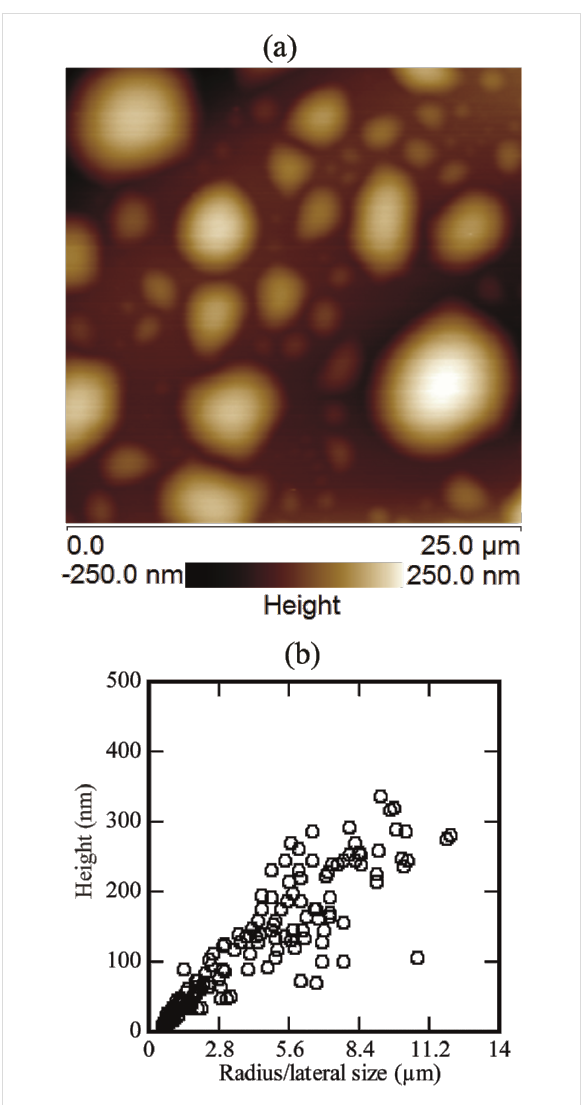
Figure 2: (a) AFM image of micro/nano spherical domains on a PS-coated surface, immersed in DI water. A number of spherical or nearly spherical objects can be seen in the image. (b) Summary of the height and radius/lateral size of the spherical domains. Additional images of the so-called spherical domains are shown in Supporting Information File 1, Figure